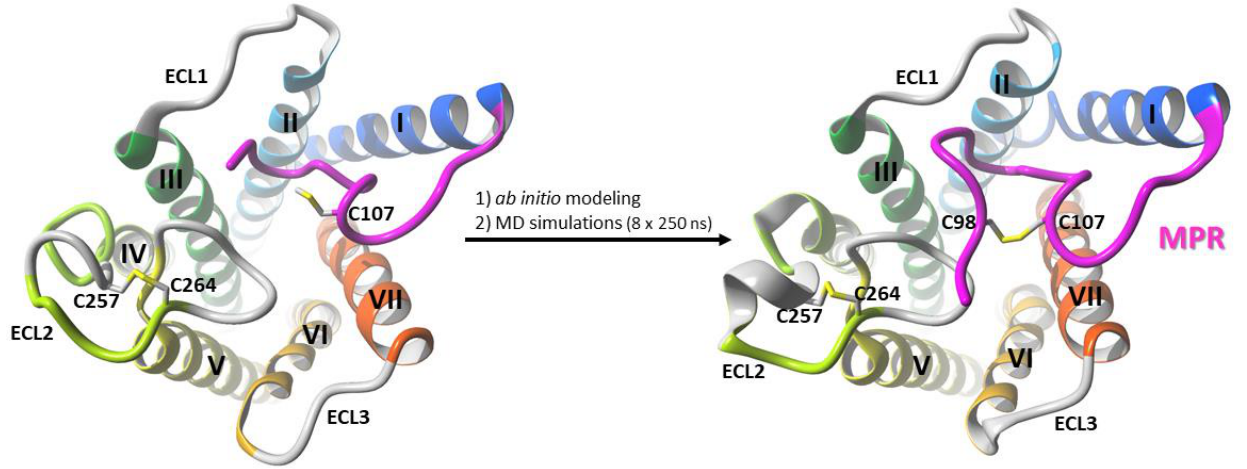
Figure 6. The modelling process of MPR of the CB 1 R N-terminal domain. Residues 96 – 99 were added to the CB 1 R crystal structure (PDB ID: 5U09) and the C98-C107 disulfide bond was created. Regions 96 – 100 and 107 – 108 were then sampled in Rosetta. Eight structures of CB 1 R with MPR obtained from Rosetta were placed in POPC bilayer and simulated for 250 ns.